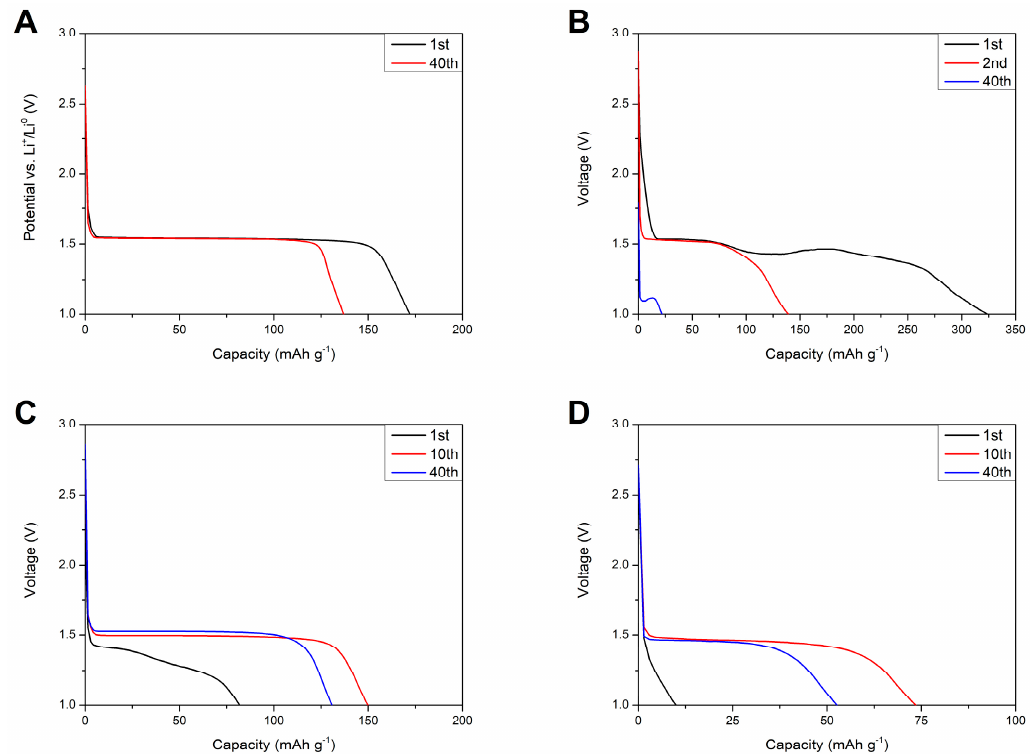
Figure 15. Discharge profiles of Li 4 Ti 5 O 12 electrodes in different environments: 1 M LiTFSI at 1 C rate and RT ( A ) and composite M separator at 0.1 C rate and at different temperatures: RT ( B ), 5 °C ( C ), and 0 °C ( D ).